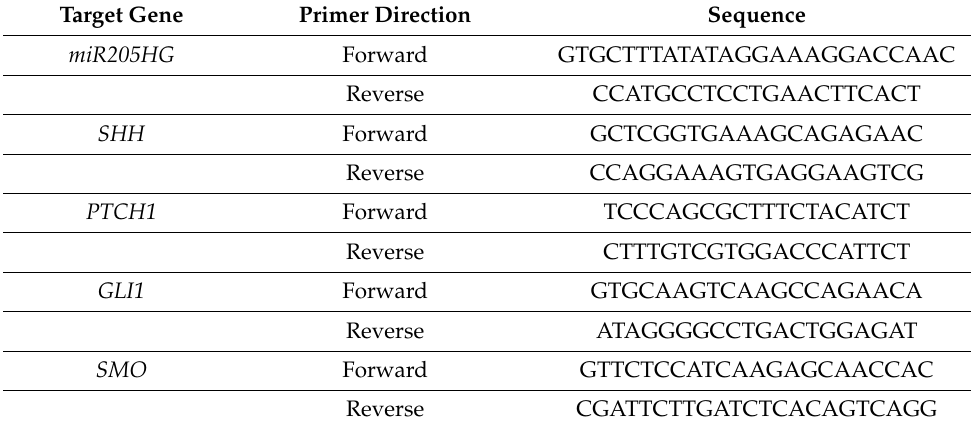
Table 1. Sequences of forward and reverse primers used for quantitative reverse transcription polymerase chain reaction